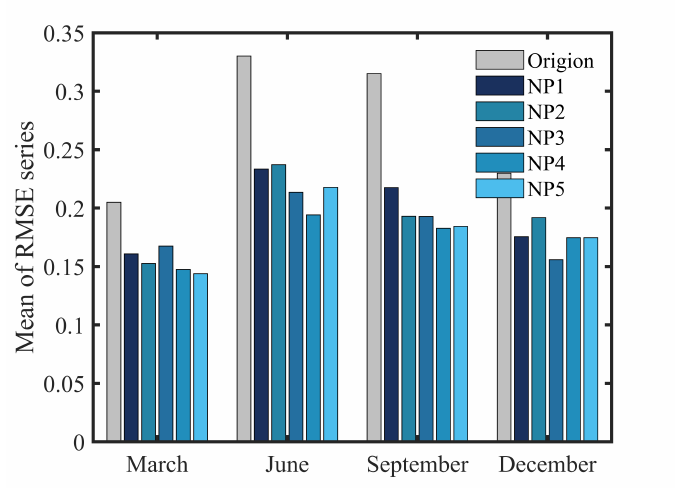
Figure 12. The influence of the number of observation platforms on the mean of RMSE series of analysis.